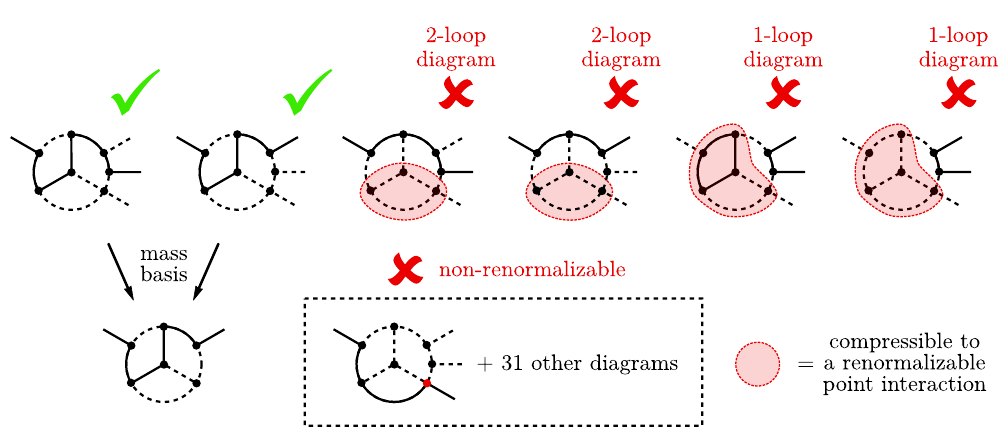
Figure 6 . There are two normal genuine diagrams associated to the topology shown in the top. There is also a total of 32 diagrams which can be drawn with a non-renormalizable fermion-fermion- scalar-scalar interaction. Finally, there are 4 diagrams which are also not normal genuine ones because it is possible to shrink a subpart of them into a renormalizable point interaction. (Note however that under some very speci(cid:12)c circumstances, the third, the (cid:12)fth and sixth diagrams in the top row can be genuine, hence they are considered special genuine